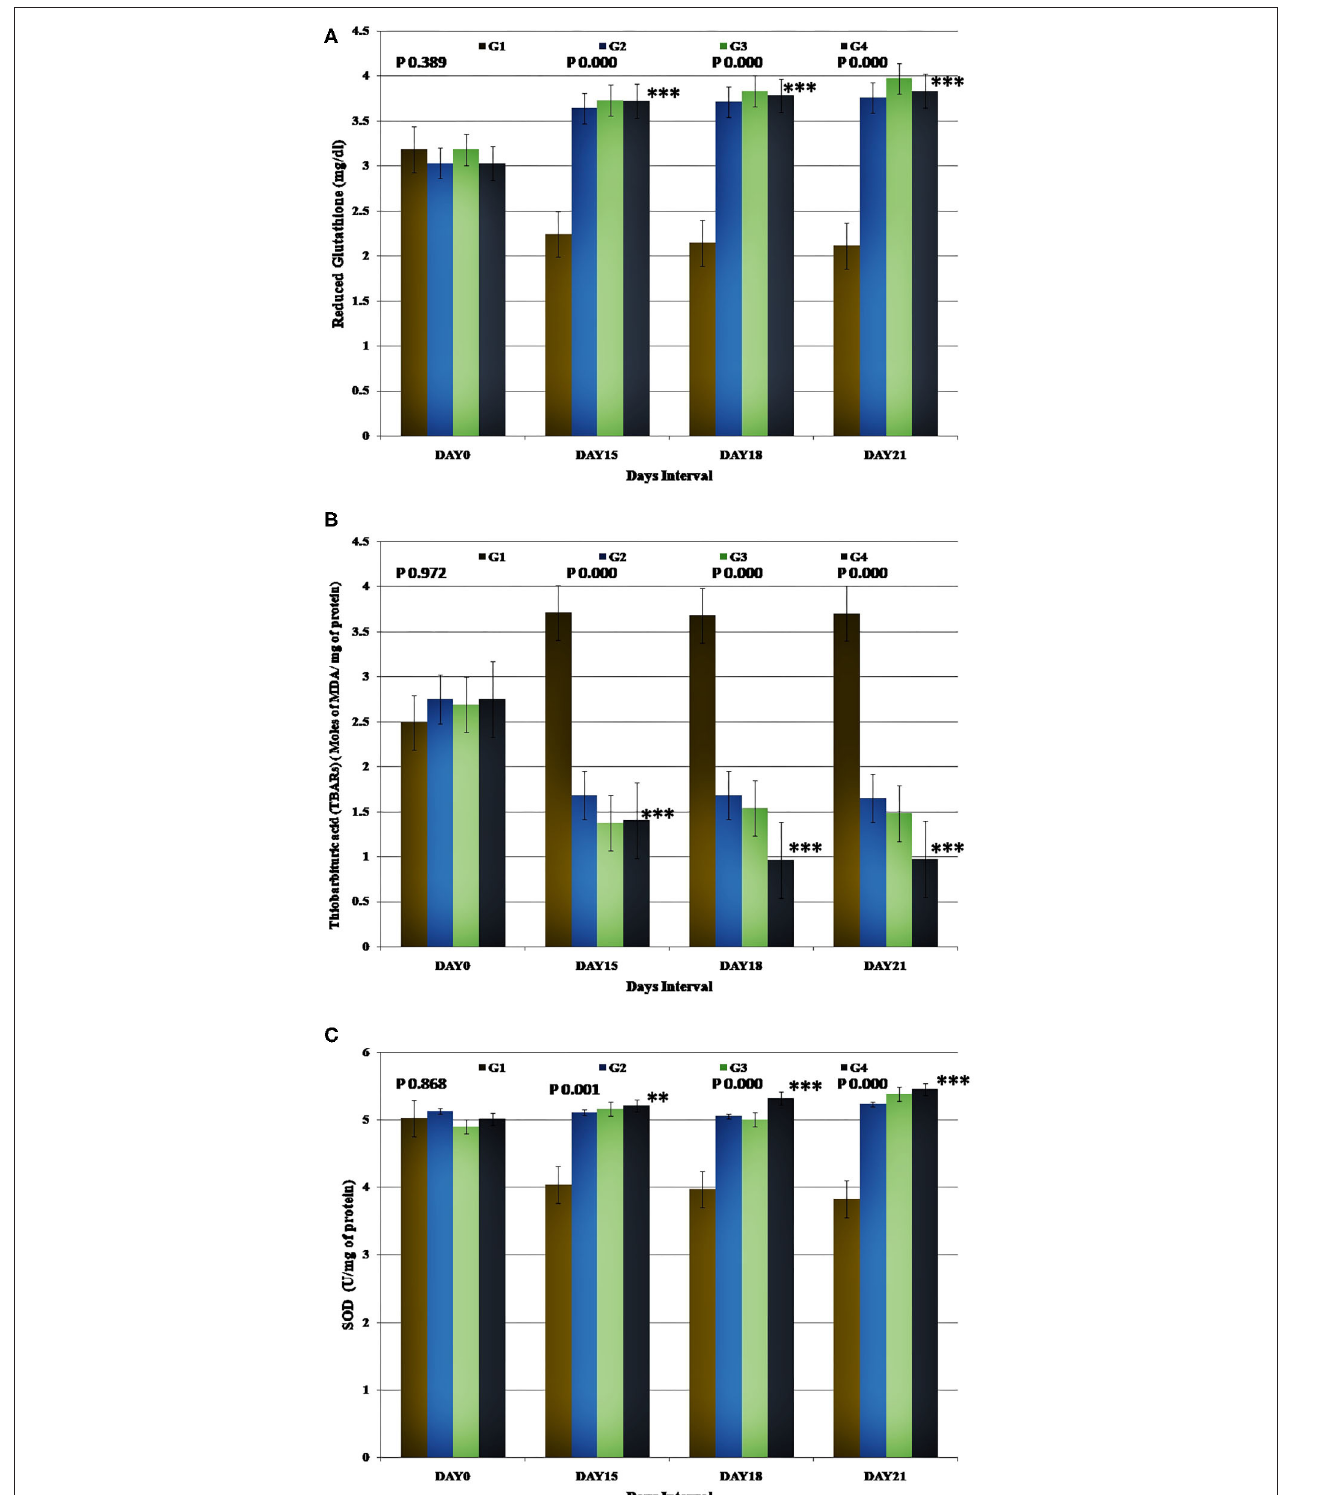
FIGURE 4 | Representation of the antioxidant assessment results for each study group. Group-specific results obtained for (A) Reduced Glutathione (GSH), (B) Thiobarbituric acid (TBARs), and (C) SOD.